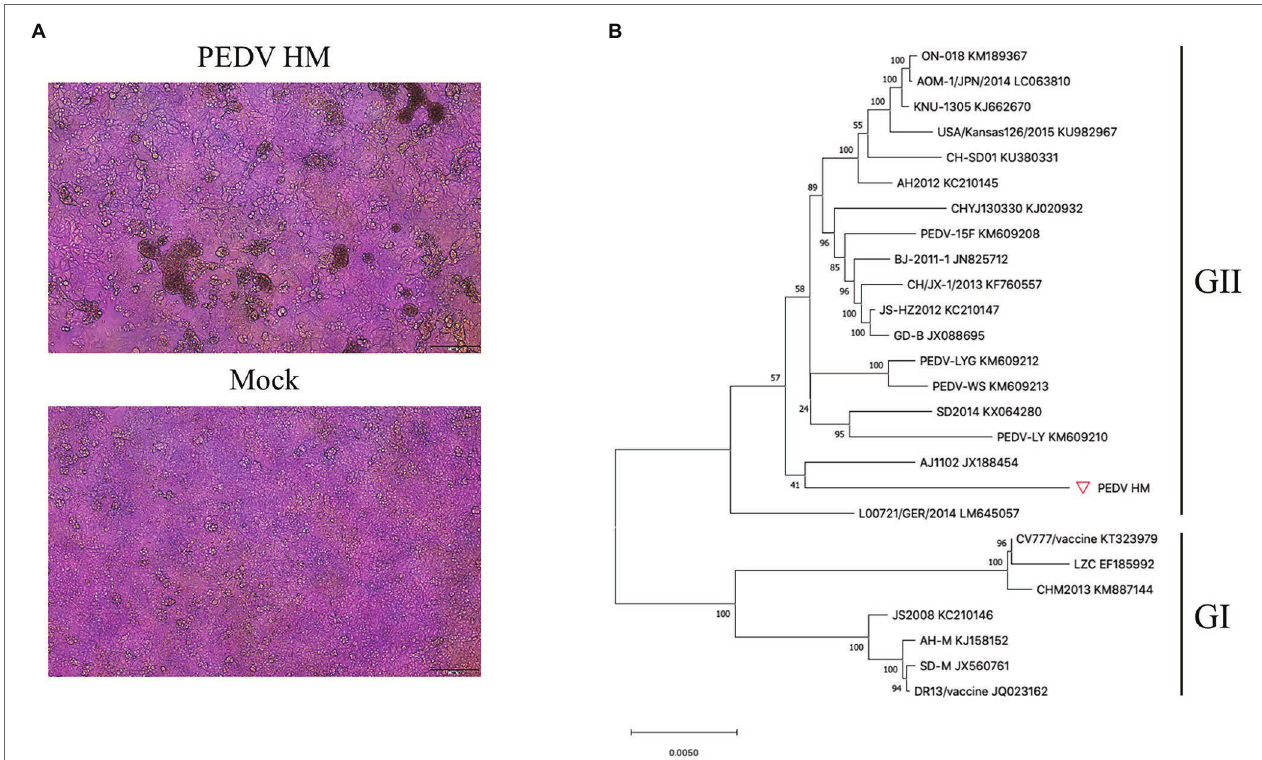
FIGURE 1 | Isolation and phylogenetic analysis of the PEDV HM strain. (A) PEDV HM infection of Vero CCL-81 cells. Vero CCL-81 cells were inoculated with PEDV HM P12 at an MOI of 0.1 or mock-infected, and cell monolayers were monitored daily for CPE under a bright field microscope. (B) Evolutionary analysis of the full- length genomic sequences of PEDV HM strain and 25 representative PEDV strains. The phylogenetic tree was generated with the neighbor-joining method using MEGAX, and bootstrap values were set as 1,000 for each node. The evolutionary distances were computed using the Maximum Composite Likelihood method and are in the units of the number of base substitutions per site. The names of the strains, GenBank accession numbers, and genogroups are